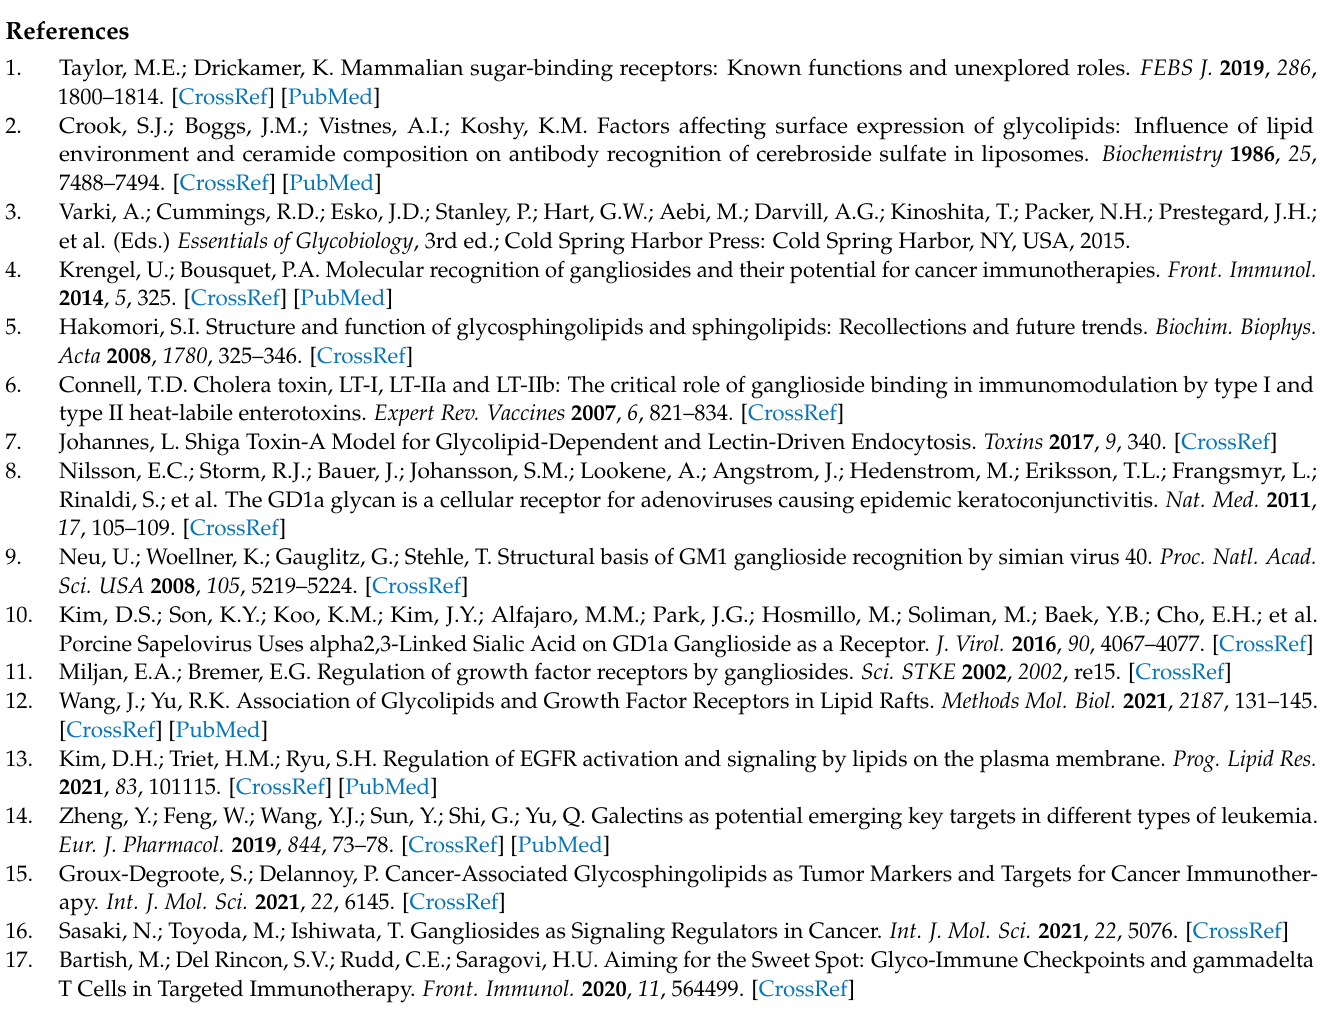
Figure S5. Initial (t = 0 ns) and final (t = 400 ns) snapshots. Figure S6. 1H assignment of asialo-GM1 and